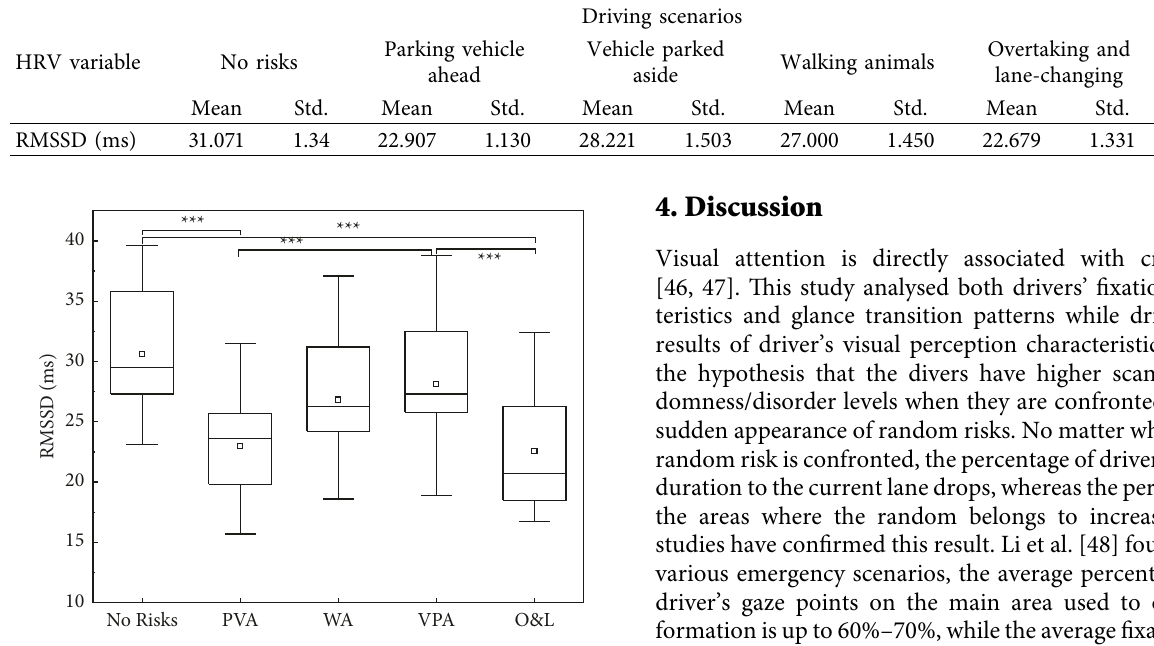
Figure 8: Comparison of driver’s time-domain index RMSSD at different types of random risk points.